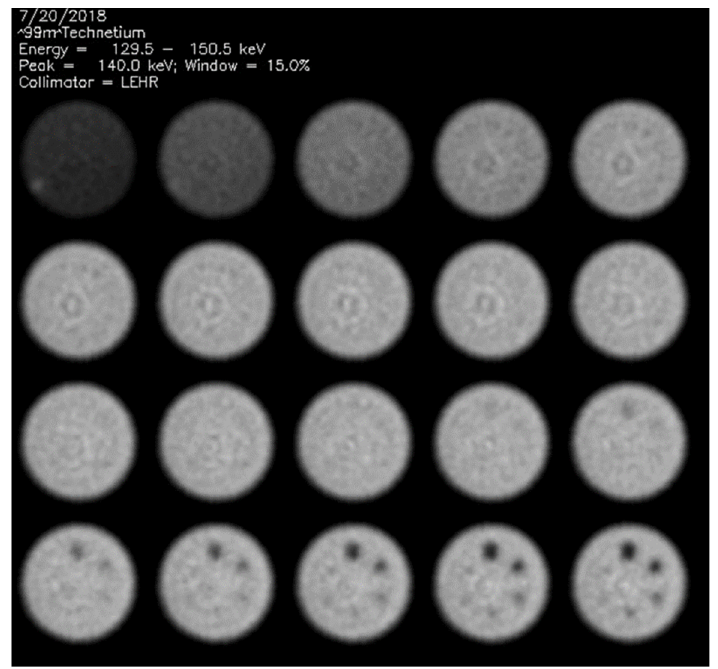
Figure 4. Example of images related to the uniform sections and spheres sections of a phantom, which both readers scored “4”, forsevere concentric ring artifacts, in both sections.